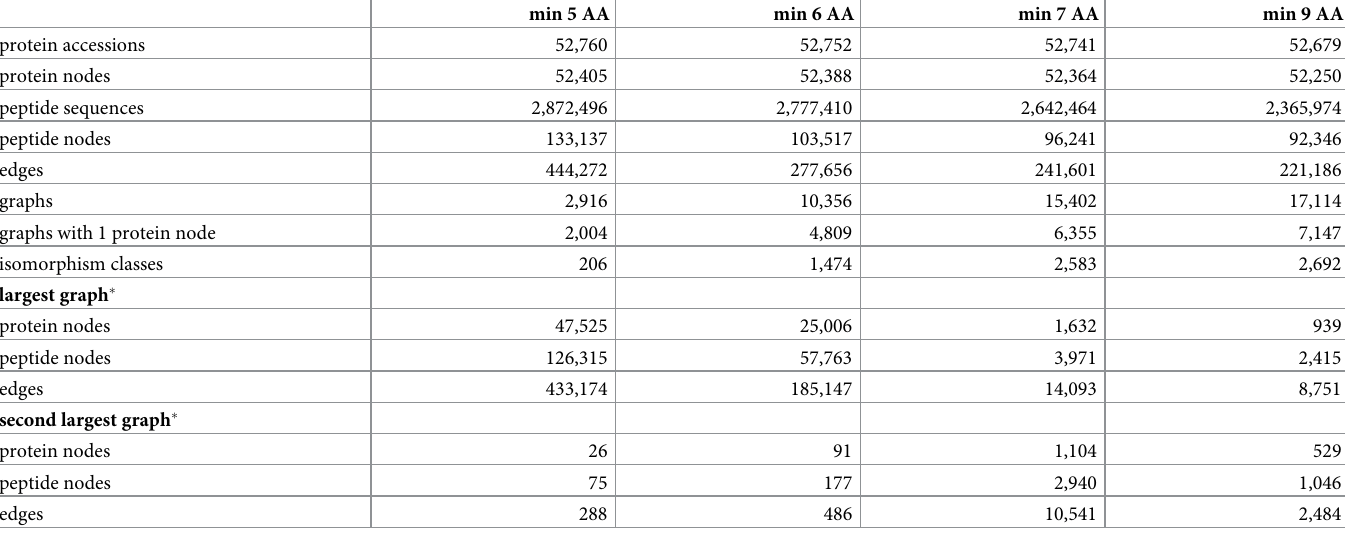
Table 1. Influence of different minimal peptide lengths on the bipartite graphs for